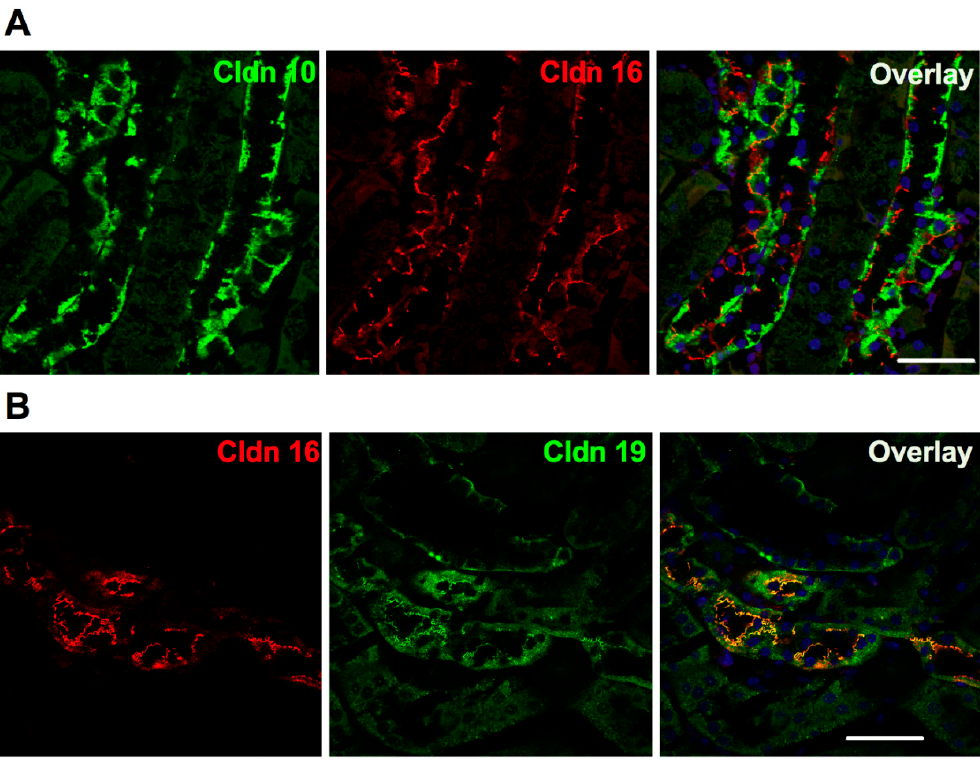
Figure 3. Expression of claudin 10, claudin 16 and claudin 19 in the murine cortical thick ascending limb in immunofluorescence. ( A ) Pattern of expression of claudin 10 and claudin 16 in the mouse C-TAL. Either claudin 10 (Cldn 10, in green) or claudin 16 (Cldn 16, in red) are expressed at tight junction. ( B ) Pattern of expression of claudin 16 and claudin 19 in the mouse C-TAL. Claudin 16 (Cldn 16, in red) and claudin 19 (Cldn 19, in green) are colocalized at tight junction. Bar = 20 µm.